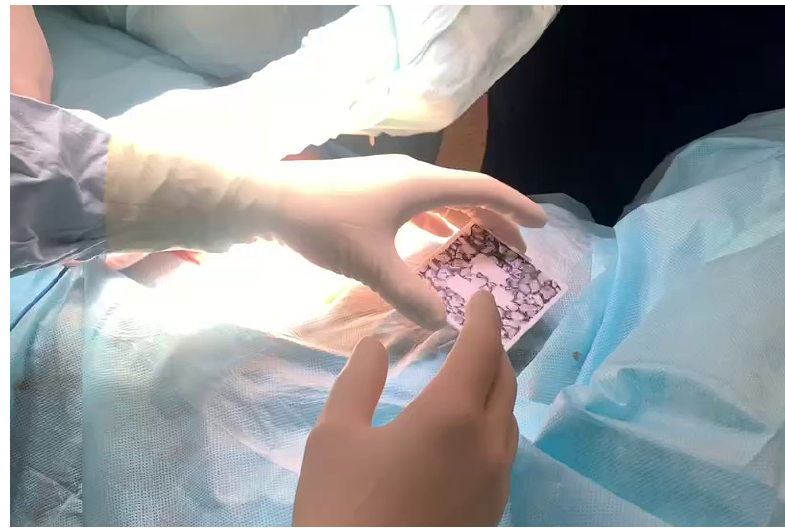
Figure 10. Moment of intraoperative marker placement in sterile conditions.